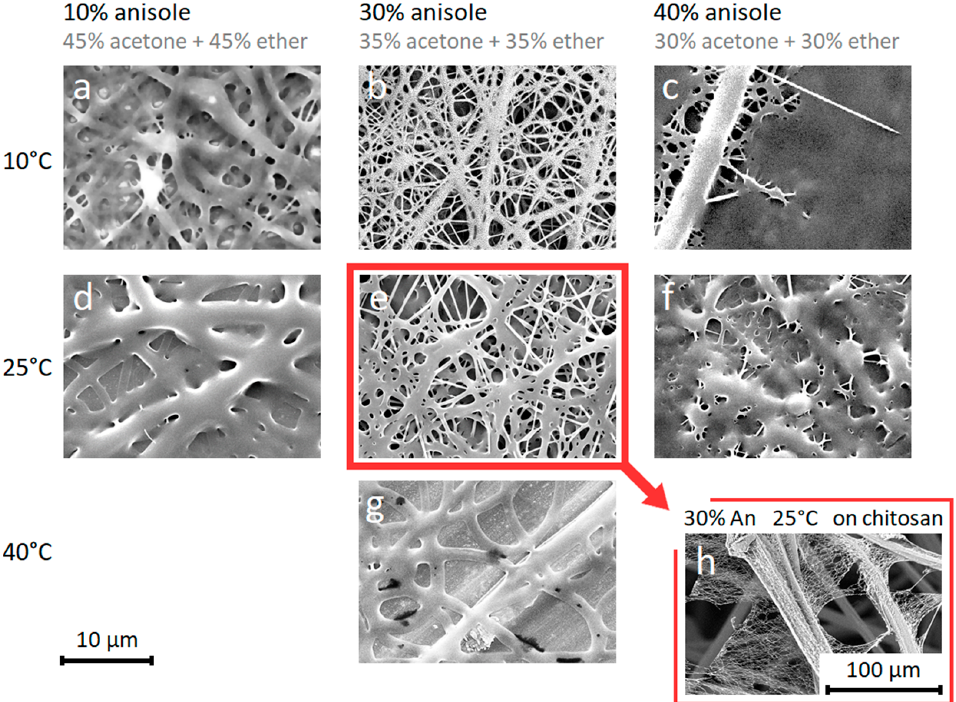
Figure 3. SEM images of 10% P(3HO- co -3HD) nanofibers with increasing anisole concentration from left to right. A lack of anisole (i.e., 10% anisole) ( a , d ) leads to too high evaporation rates resulting in thick fibers, while too much anisole (i.e., 40% anisole) ( c , f ) prevents sufficient evaporation resulting in fibers that are too wet, causing the polymer to fuse. When electrospinning at temperatures (i.e., 40 °C) too far above the polymer’s Tg ( g ), the polymer retains too much solvent after deposition resulting in thick fused fibers. The 30% anisole solutions at 10 °C ( e ) and 25 °C ( b , h ) result in a porous membrane at thin electrospinning layers, which can be deposited directly onto a chitosan carrier.